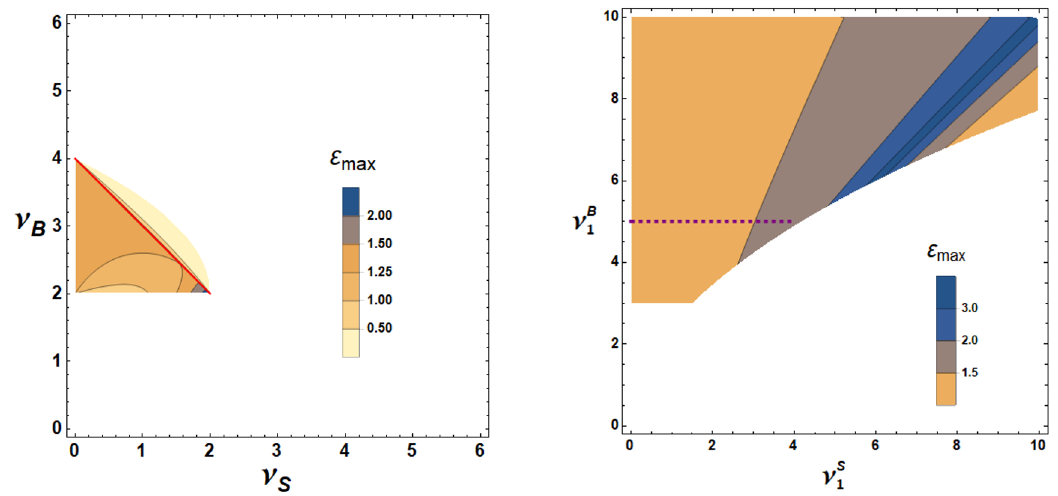
Figure 7 . Summary of the main di(cid:11)erences between the nonlinear elasticity bounds found for materials with spontaneously broken (left) or manifest (right) scale invariance. Both materials present power-law stress-strain relations (cid:27) (cid:24) " (cid:23) (at " (cid:29) 1) with exponents (cid:23) B and (cid:23) S for pure-bulk and pure-shear deformations. Both the values of the maximum allowed deformation " max as well as the range of values of the allowed exponents di(cid:11)er